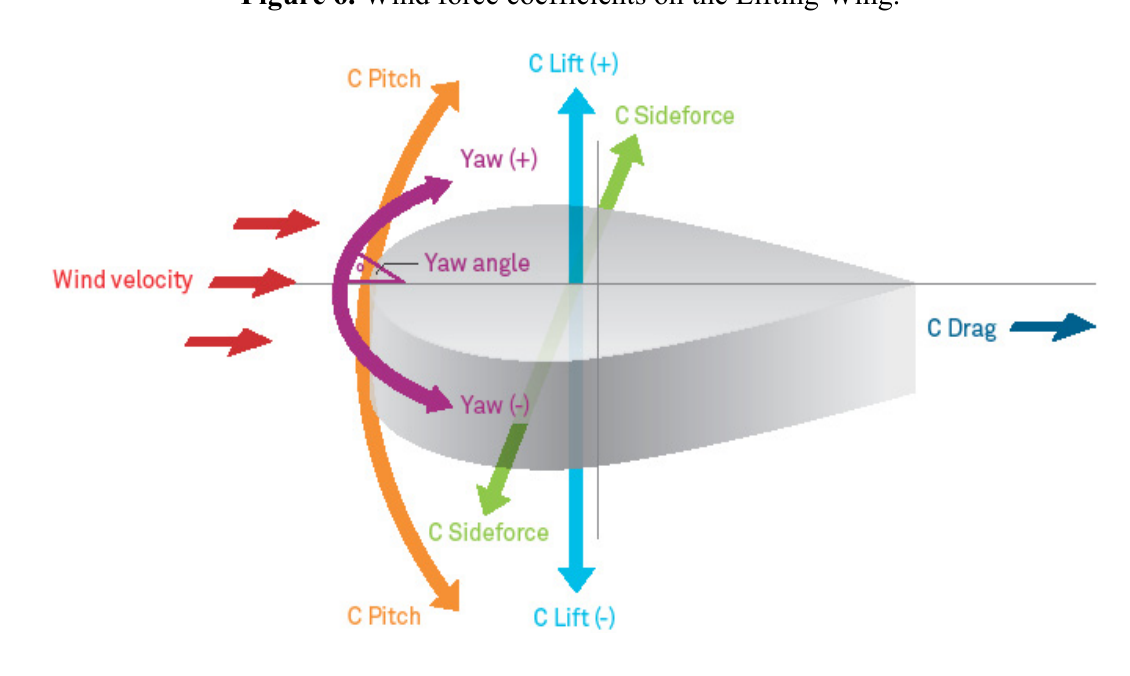
Figure 6. Wind force coefficients on the Lifting